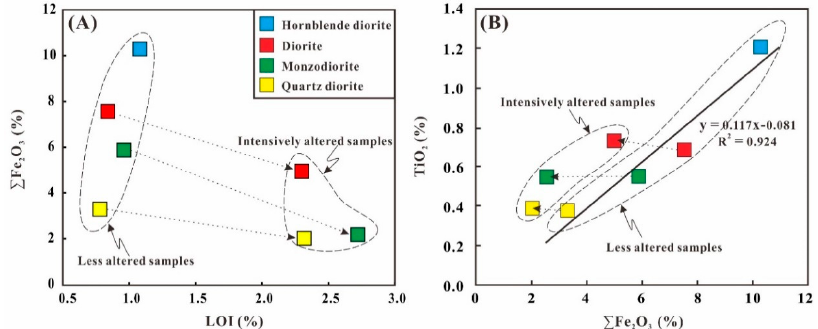
(cid:80) Figure 3. ( A ) ∑ Fe 2 O 3 vs. loss on ignition (LOI) diagram of intrusive rocks with different lithologies, Figure 3. ( A ) Fe 2 O 3 vs. loss on ignition (LOI) diagram of intrusive rocks with di ff erent lithologies, (cid:80) especially for the less altered and intensively altered samples. ( B ) ∑ Fe 2 O 3 vs. TiO 2 diagram of intrusive especially for the less altered and intensively altered samples. ( B ) Fe 2 O 3 vs. TiO 2 diagram of rocks with different lithologies, especially for the less altered and intensively altered samples.